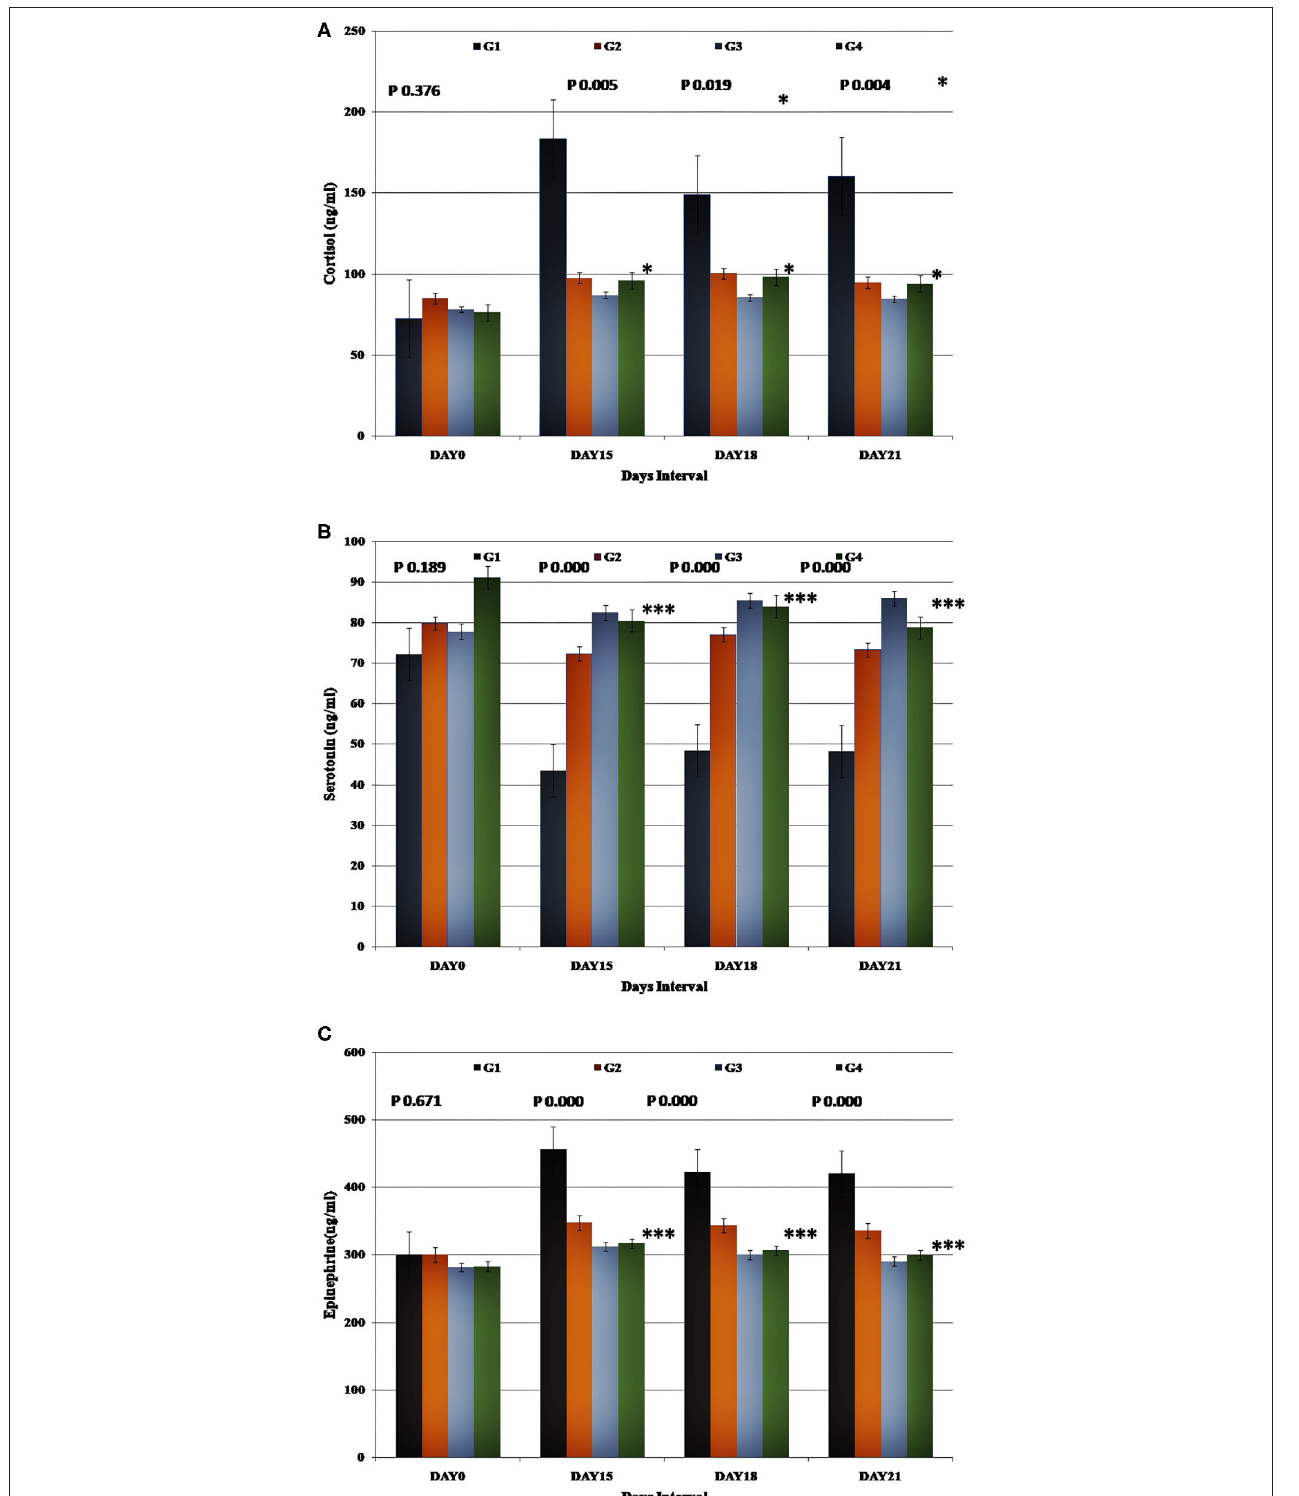
FIGURE 3 | Presentation of the endocrinological parameters recorded for each study group. Group-specific results obtained for (A) cortisol, (B) serotonin, and (C) epinephrine.